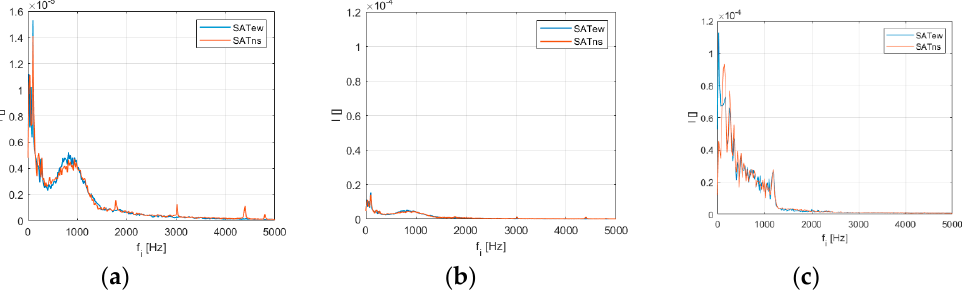
Figure 4. Illustrative spectra obtained from Bew and Bns for the pulse 30492 that has also been shown in Figure 3. ( a , b ): ELMy spectra without a rotating mode -evaluated averaging the spectra obtained from 4.0 s to 4.5 s with a time window of 50 ms- ( c ) spectra close to the disruption t disr = 7.516s (with the same scale of ( b )) –evaluated averaging the spectra obtained from 7.465 s to 7.515s with a time window of 50ms.